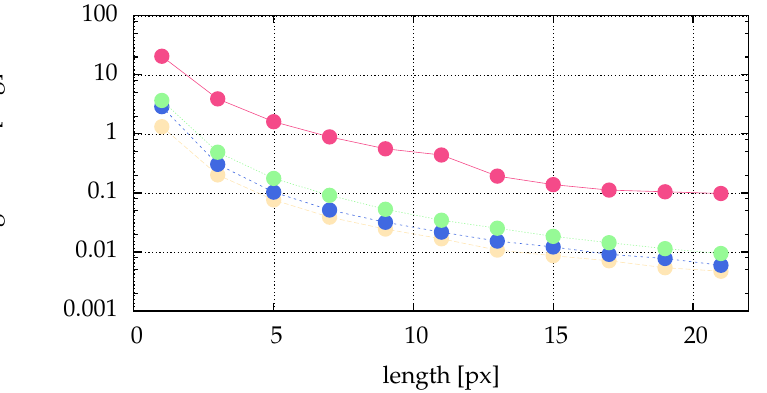
Figure 14. Comparison of angle errors for different lengths of the stripe and different particle sizes: pink ( (cid:4) ) for σ = 0.1, yellow ( (cid:4) ) for σ = 0.5, blue ( (cid:4) ) for σ = 1 and green ( (cid:4) ) for σ = 2. The angle was varied between 0 ◦ and 90 ◦ in 19 equal steps. To overcome the dependence on the subpixel position shown in Figure 10 we averaged over 100 equally destributed subpixel positions. This means, every plotted length error is an average of 1900 analyzed artificial stripes. The scale of the ordinate is